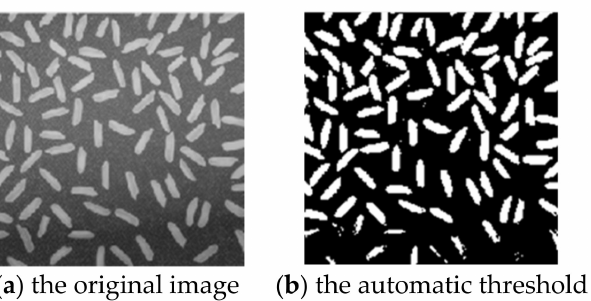
Figure 2. Segmentation effect of image using automatic threshold